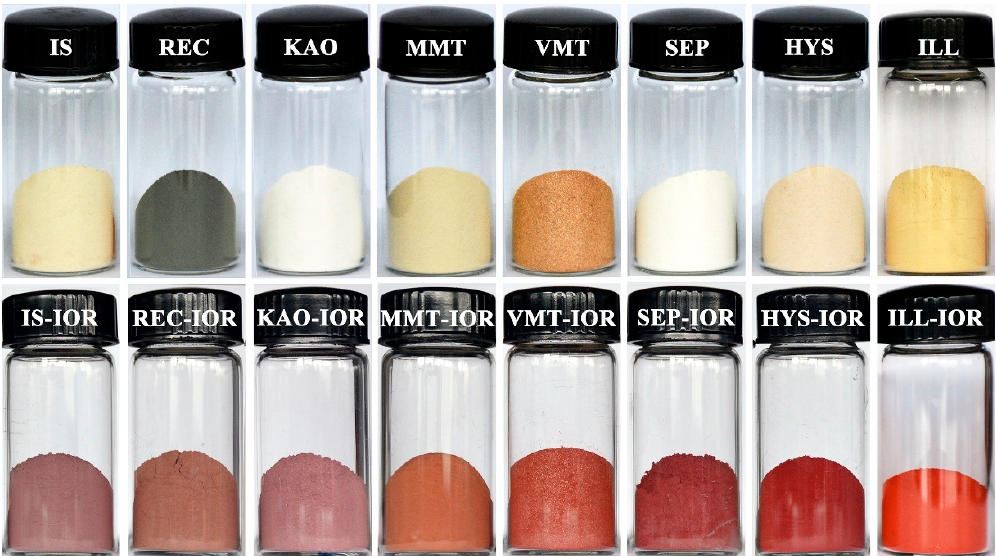
Figure 6. Digital photos of the used natural clay minerals and the corresponding hybrid pigments (For interpretation of the references to color in this figure legend, the reader is referred to the web version of this article).